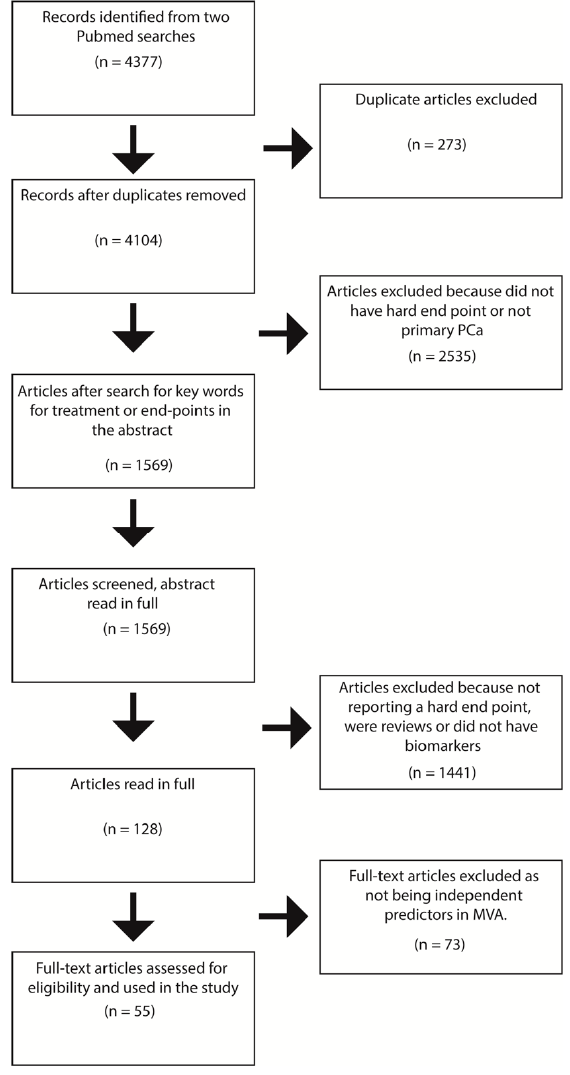
Figure 1. PRISMA diagram of the systematic review. MVA = Multivariable analysis. Table 1. Results of the systematic Pubmed search (for detailed inclusion criteria, see text and Appendix A). Biomarkers independently related to clinically relevant outcomes in localized prostate cancer. Source Material, Ref. Analysis